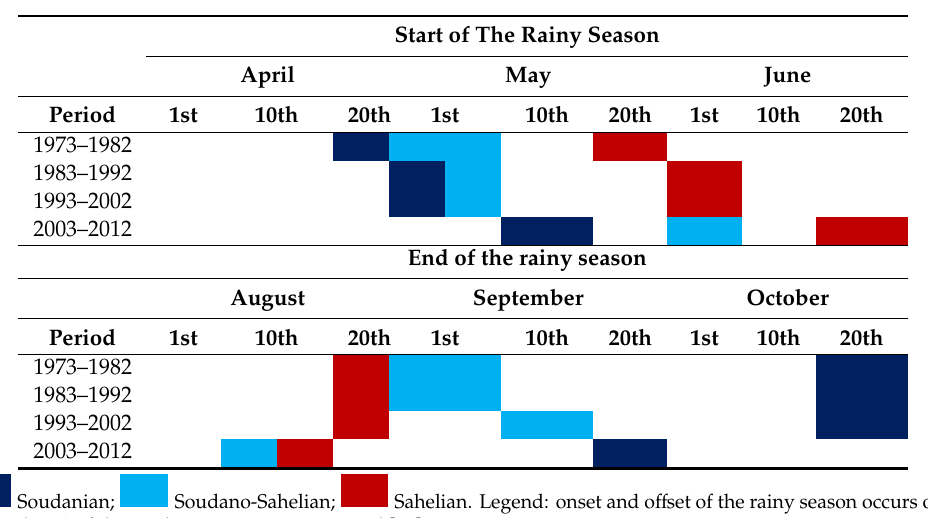
Legend: average precipitation for Bobo Dioulasso (983 mm), Ouagadougou (667 mm), and Dori (405 mm) for the period 1973–2017. Table 5. Changes in dry-spell frequency (seven days or more without rain) and precipitation intensity (>20 mm day − 1 ) along the different agroclimatic zones (Soudanian, Soudano-Sahelian, and Sahelian) for the period 1973–2017. Soudanian